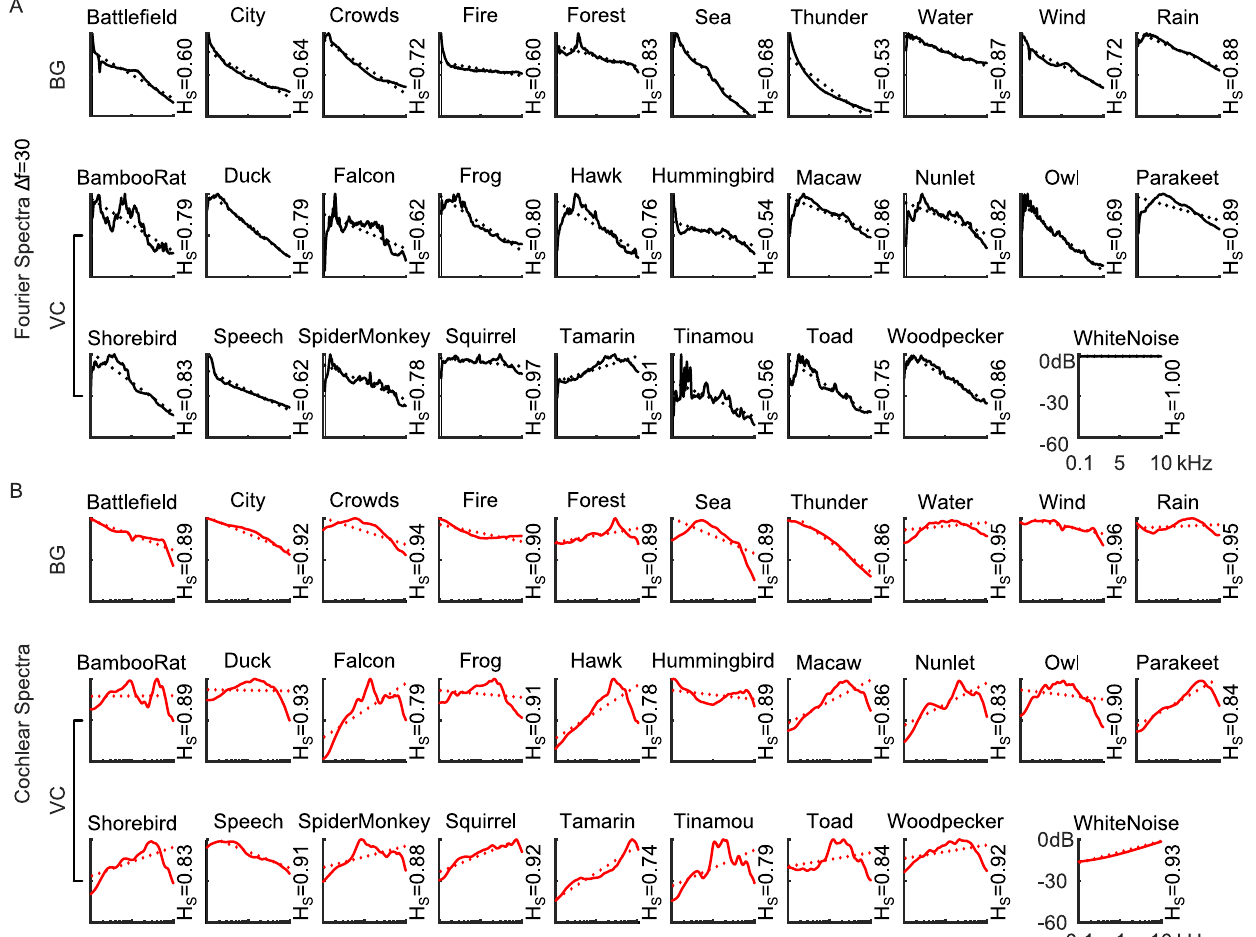
Fig 4. Spectra of vocalizations (VC) and background (BG) natural sound ensembles. Power spectra are shown for both the (A) cochlear and (B) Fourier-based model representations. Dotted lines represent the best linear fit between 0.1–10 kHz. All but one of the natural sounds have a Fourier spectrum with negative slope, while cochlear spectrums, by comparison, have more varied slopes (positive and negative) indicating a more even distribution of power across frequencies. The spectral entropy of each sound category is listed on the right side of the panel.